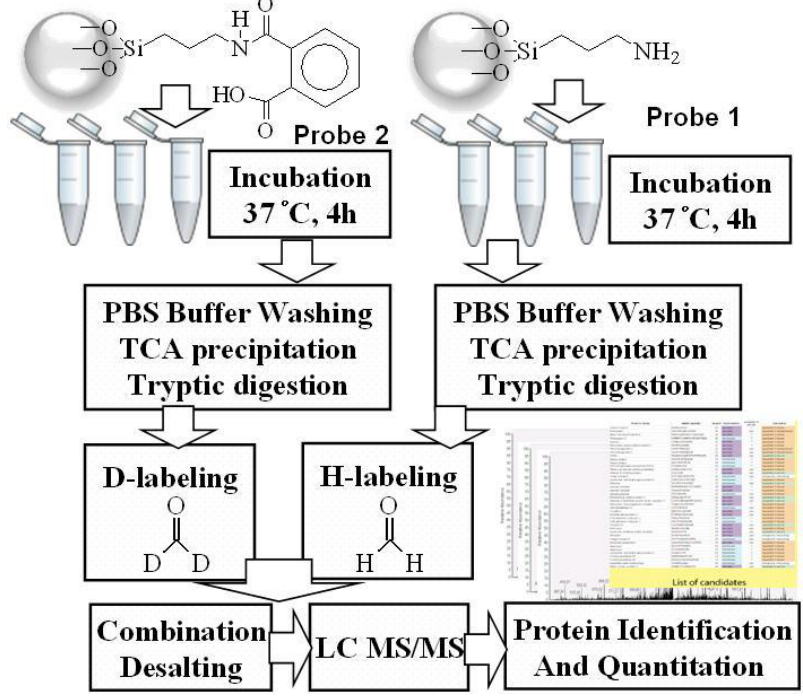
Figure 1. Flowchart of cell treatments and quantitation of proteins in MCF-7 and MDA-MB-231 cell using a phthalic acid chemical